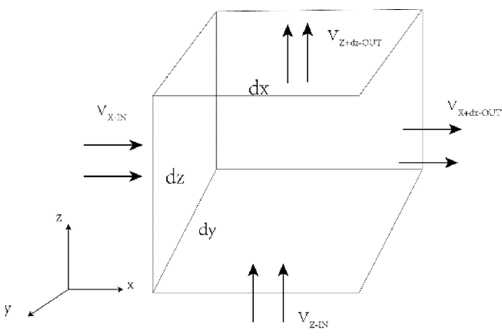
Figure 2. Schematic diagram of an element within the fracture. A PKN model is implemented to calculate the fracture dimensions. Because the fracture width (y direction) is much smaller than the fracture length (x direction) and the fracture height (z direction), the fluid flow in the y direction can be neglected. The equation of fluid continuity within the fracture is obtained based on the law of conservation of mass: